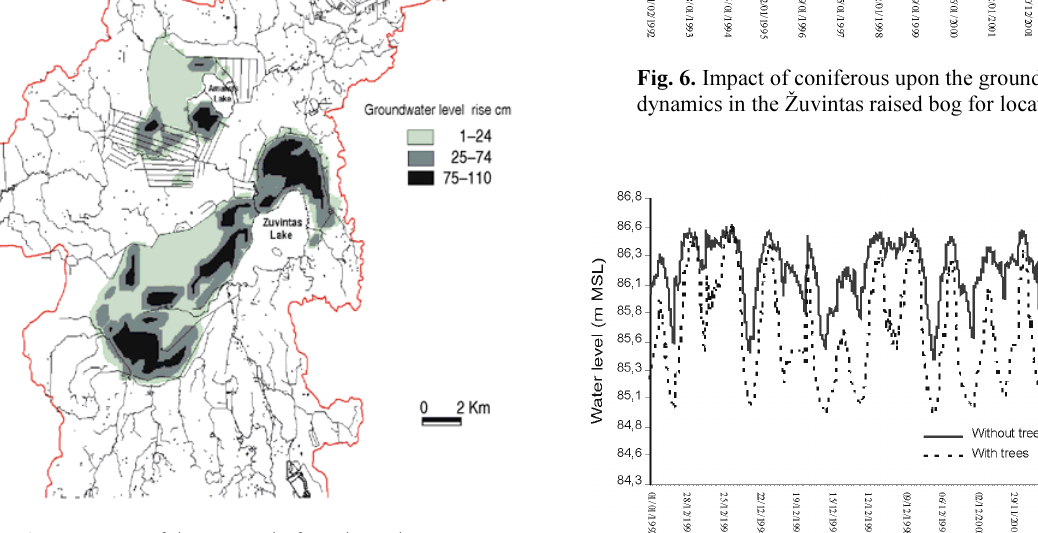
Fig. 5. Impact of the removal of scrubs and trees on groundwater level changes in the Žuvintas and Amalvas wetlands